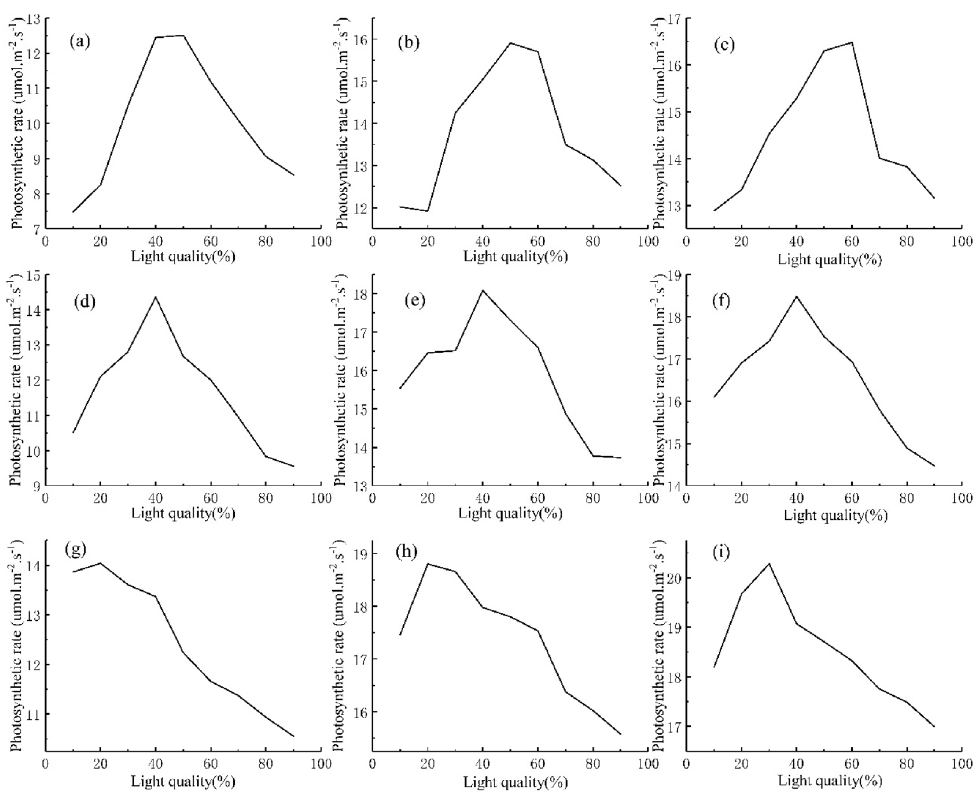
Figure 3. The change of photosynthetic rate with light quality: ( a ) At the temperature of 18 °C and the light intensity of 400 μmol/(m 2 ·s); ( b ) At the temperature of 18 °C and the light intensity of 800 μmol/(m 2 ·s); ( c ) At the temperature of 18 °C and the light intensity of 1200 μmol/(m 2 ·s); ( d ) At the temperature of 24 °C and the light intensity of 400 μmol/(m 2 ·s); ( e ) At the temperature of 24 °C and the light intensity of 400 μmol/(m 2 ·s); ( f ) At the temperature of 24 °C and the light intensity of 400 μmol/(m 2 ·s); ( g ) At the temperature of 18 °C and the light intensity of 400 μmol/(m 2 ·s); ( h ) At the temperature of 18 °C and the light intensity of 400 μmol/(m 2 ·s); ( i